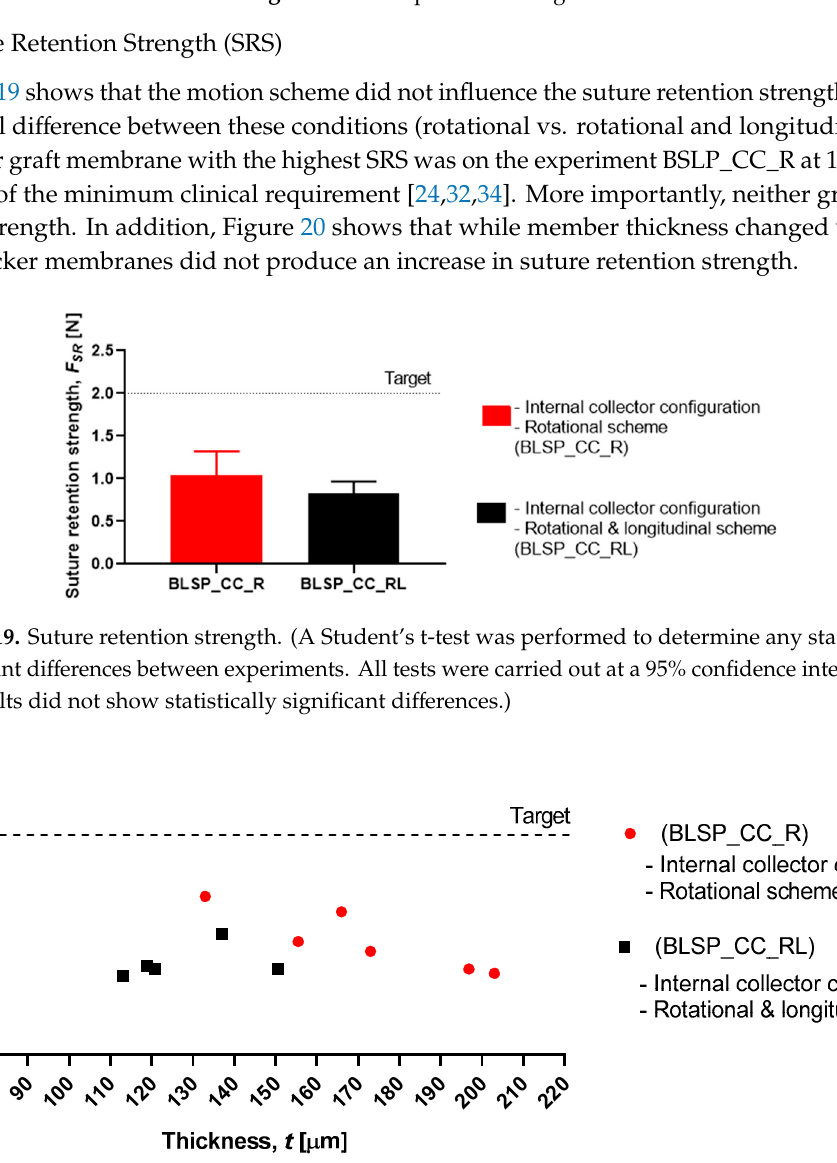
Figure 18. Burst pressure strength.